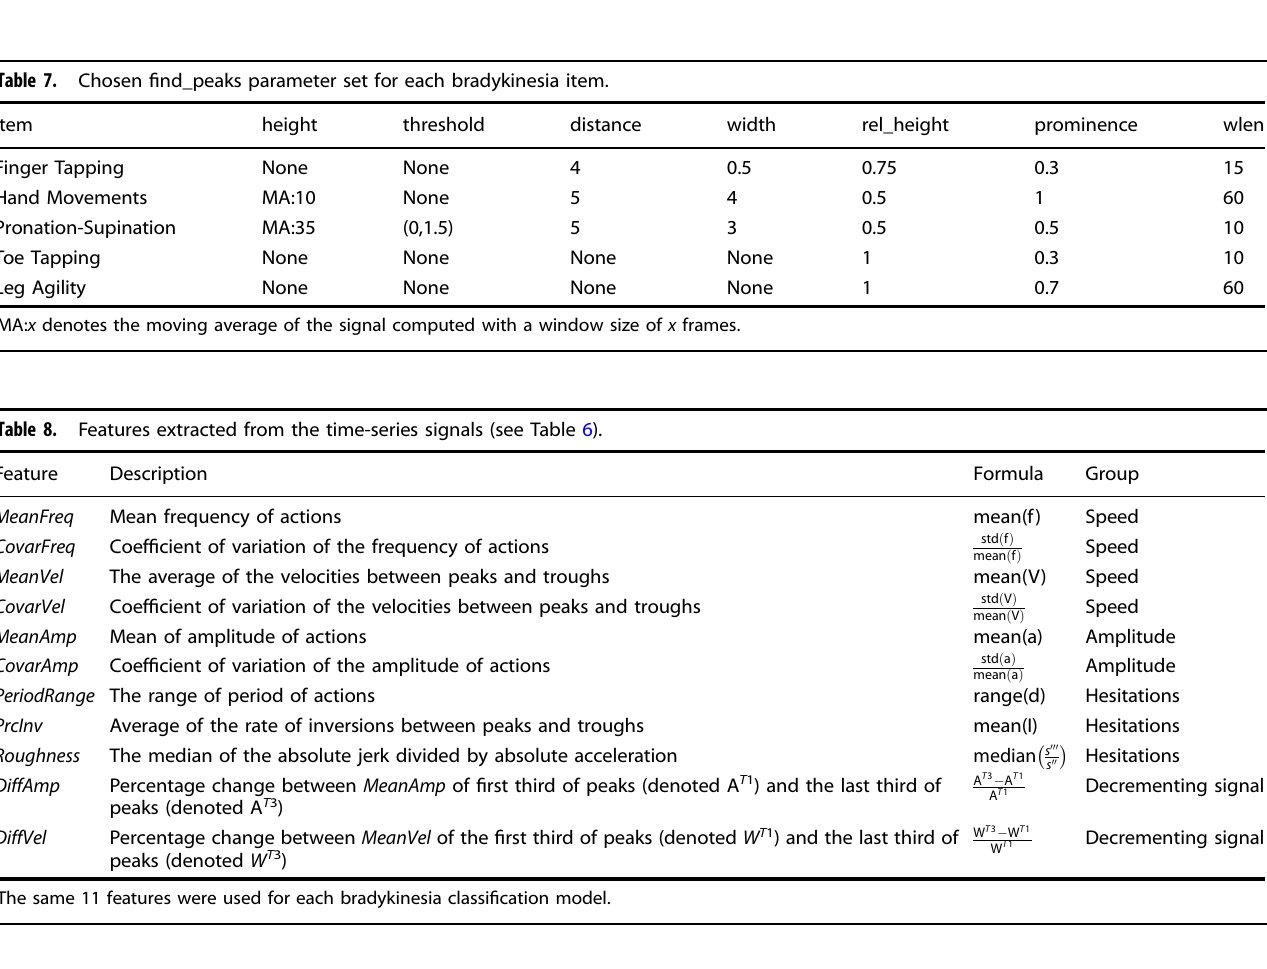
Table 6. Signals constructed from key-points and used for feature extraction for each of the fi ve bradykinesia items. MDS-UPDRS item Finger Tapping Hand Movement The area of the convex hull (ACH) of the four fi nger tips key-points and the palm key-point, measured in units of estimated-standing-height squared (H 2 ). Pronation-Supination The angular velocity of the vector from the thumb-tip key-point to the little- fi nger-tip key- points, measured in degrees per frame. Toe Tapping The vertical distance between the small toe and the neck, measured in units of estimated- standing height. Leg Agility The Euclidean distance between the knee key-point and the neck key-point, measured in units of estimated-standing height.